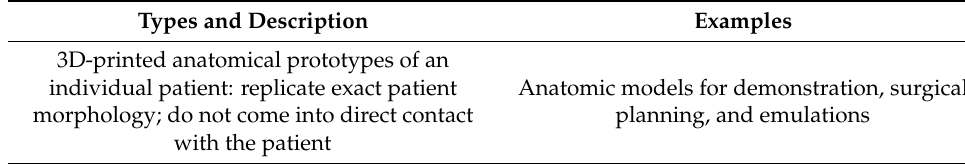
Table 1. Two types of 3D-printed objects in healthcare